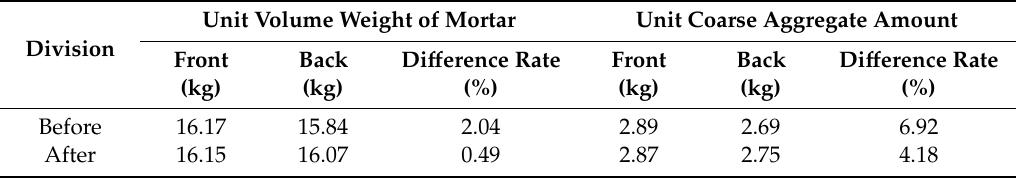
Table 2. Experimental results of Unit Volume Weight of Mortar and Unit Coarse Aggregate